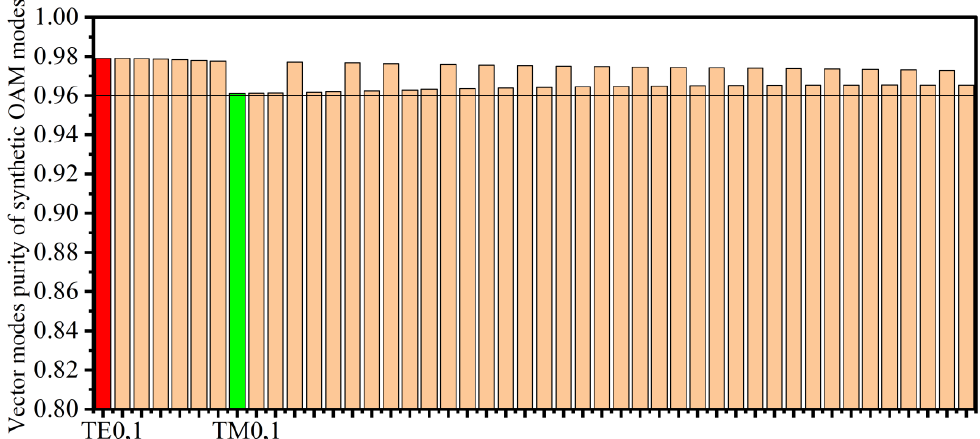
Figure 13. Mode purity of different vector modes at 1550 nm.